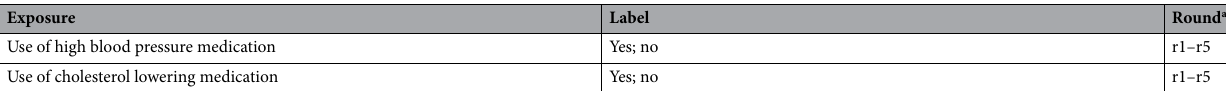
Table 1. Overview of demographic, lifestyle, environmental, and biological exposures included in the current study. a Measurement rounds during which an exposure was measured (round 1 20–59 years, round